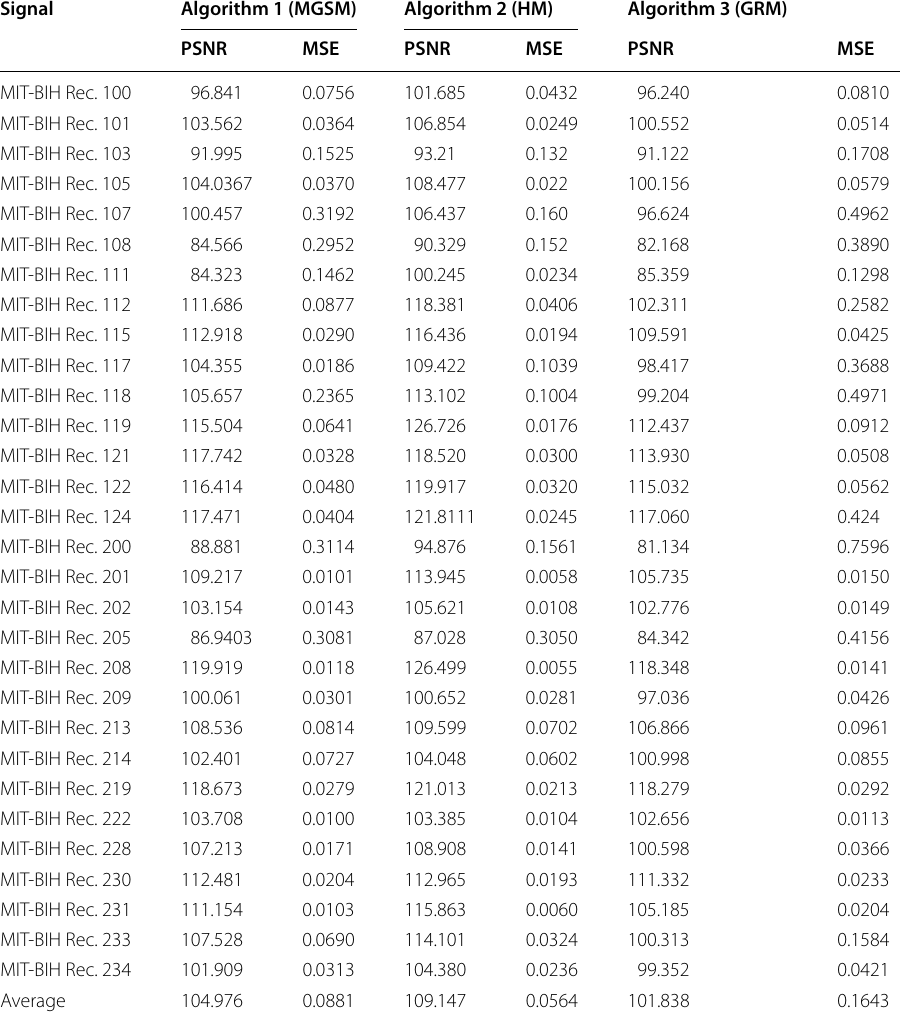
Table 3 Comparison of reconstruction errors (PSNR and MSE) for re-orthogonalization methods (MGSM, HM, and GRM) using Tchebichef moments